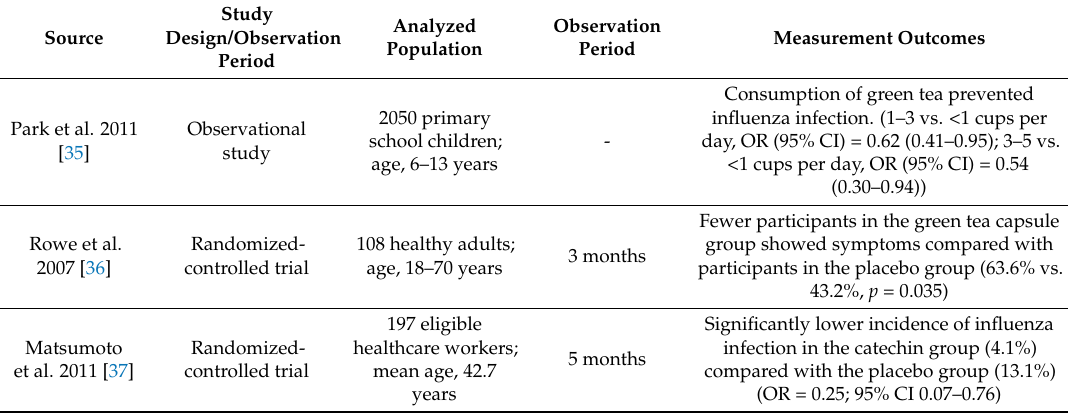
Table 1. Characteristics of major studies on tea and its ingredients against influenza